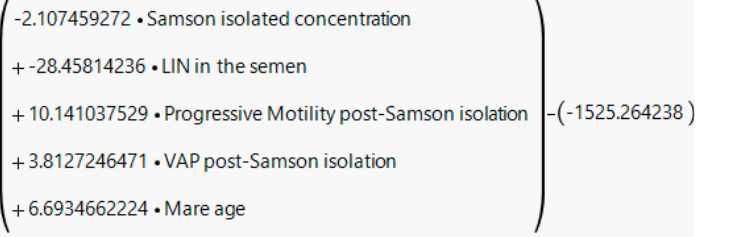
Figure A6. Equation generated when all continuous variables from the post-chilled data set, were made available from all stallions achieving a predictive accuracy for the whole group of 69.6%.